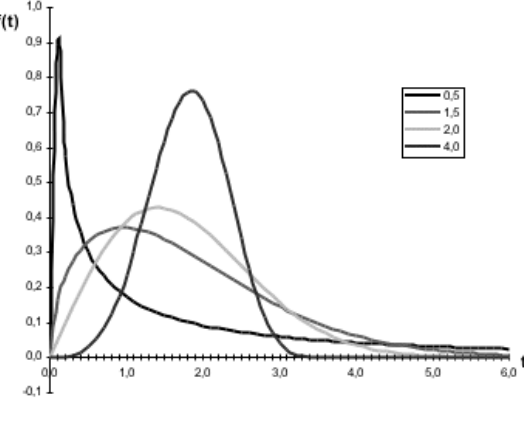
Fig. 3. Weibull failure distributions with different shape